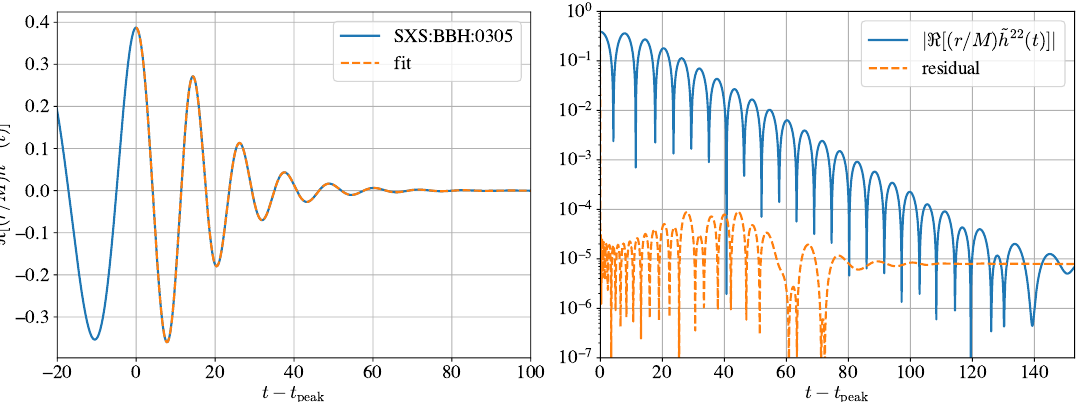
Figure 8. ( Left ) the ( (cid:96) = 2, m = 2 ) spheroidal harmonic mode of the NR waveform SXS:BBH:0305 (the blue solid line) and the QNM fit including overtone with orthonormalized mode functions introduced in Equation (37) (the orange dashed line). ( Right ) the NR data (the blue solid line) and the fit residuals (the orange dashed line).